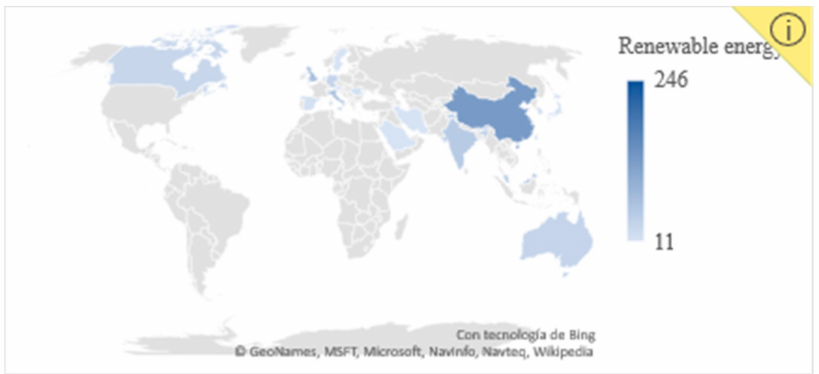
Figure 7. Countries with the biggest volume of research in renewable energy + green